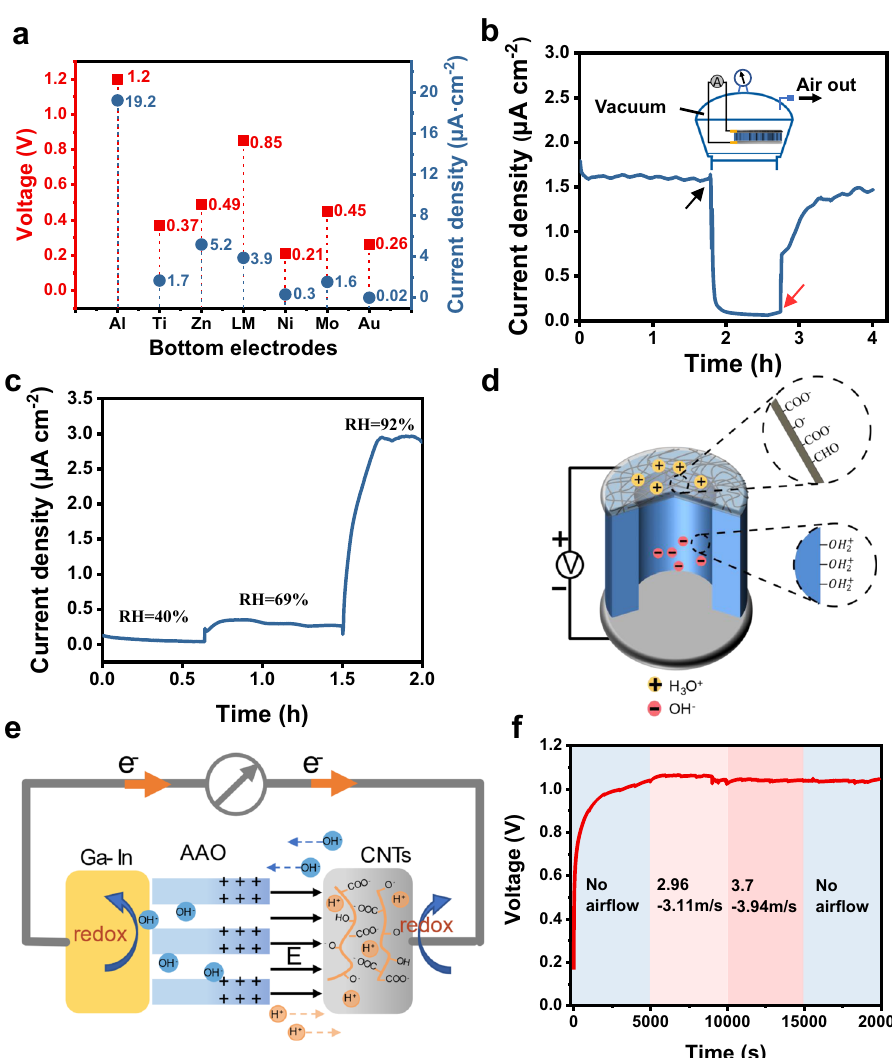
Fig. 4 Electrical output of HEEG under different conditions. a Performance diagram of devices made of different metal materials as bottom electrodes. b When the moisture (test condition 25 °C, 93% RH) in the container is pumped away (inset), the continuous current output of HEEG from the surrounding environment is destroyed (black arrow). Until the moisture is re fi lled, the current begins to return to its original value (red arrow). c The current changes continuously with the relative humidity. d Cartoon shows the functional groups existing on the CNT and AAO surface. e Schematic depiction of the harvesting moisture energy process. f When HEEG is exposed to the air fl ow environment of different wind speeds, its voltage performance has no obvious change, indicating that the air fl ow has little effect on the HEEG voltage